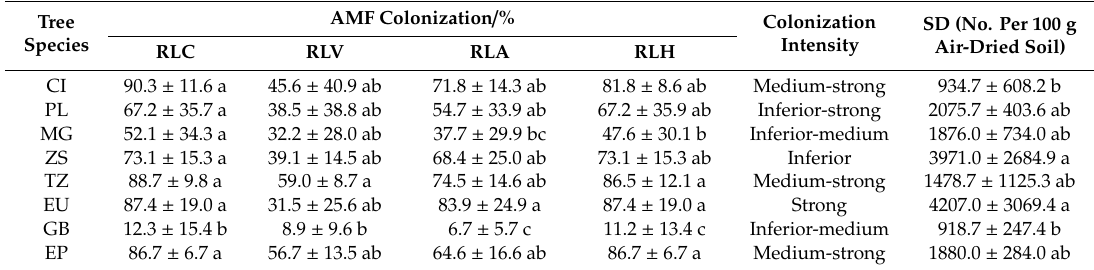
Table 1. Arbuscular mycorrhizal fungi (AMF) colonization statuses of roots and spore density in the rhizosphere soils of trees.